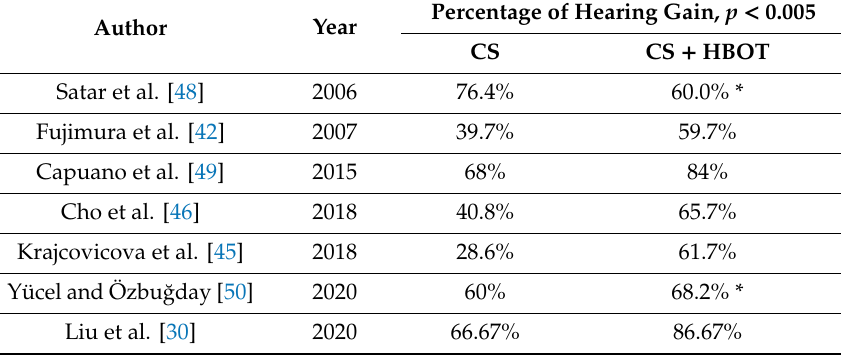
Table 1. The percentage of hearing gain and recovery in comparative studies of hyperbaric oxygen therapy (HBOT) and pharmacotherapy with corticosteroids (CS) in sudden sensorineural hearing loss